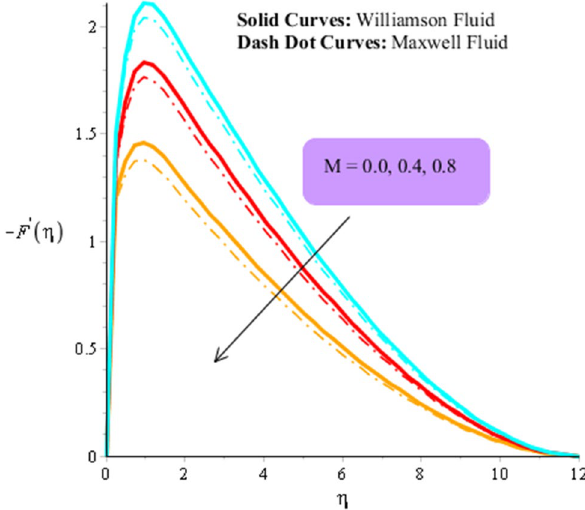
Figure 4. Influence of M versus primary velocity filed.